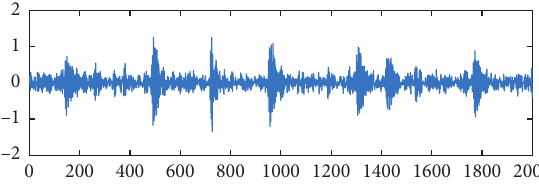
Figure 8: A vibration signal sample of outer race fault. Table 3: 6 statistical parameters.